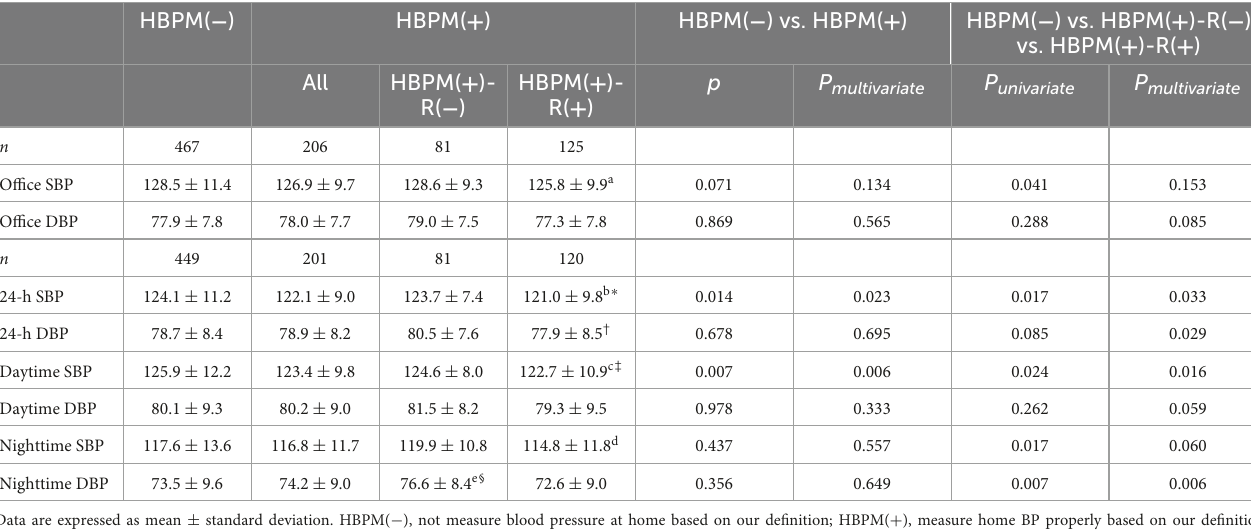
TABLE 3 Blood pressure differences.